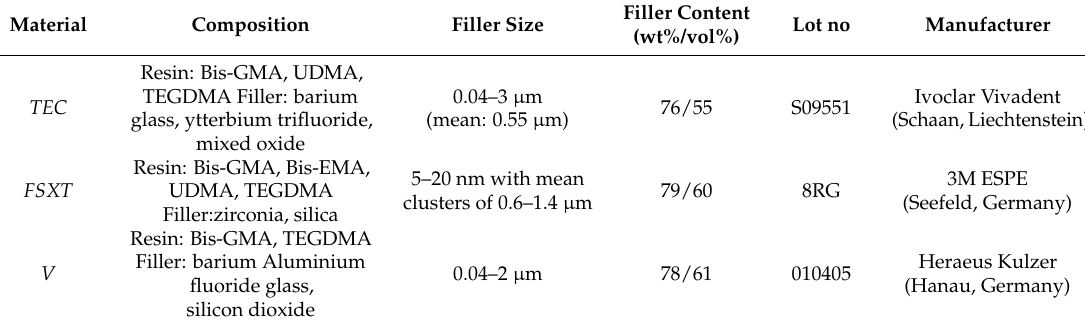
Table 1. Designation of the resin composites (RCs) used in the present study. Showing composition, filler size, and filler content according to manufacturer instruction as well as used lot number (lot no.).